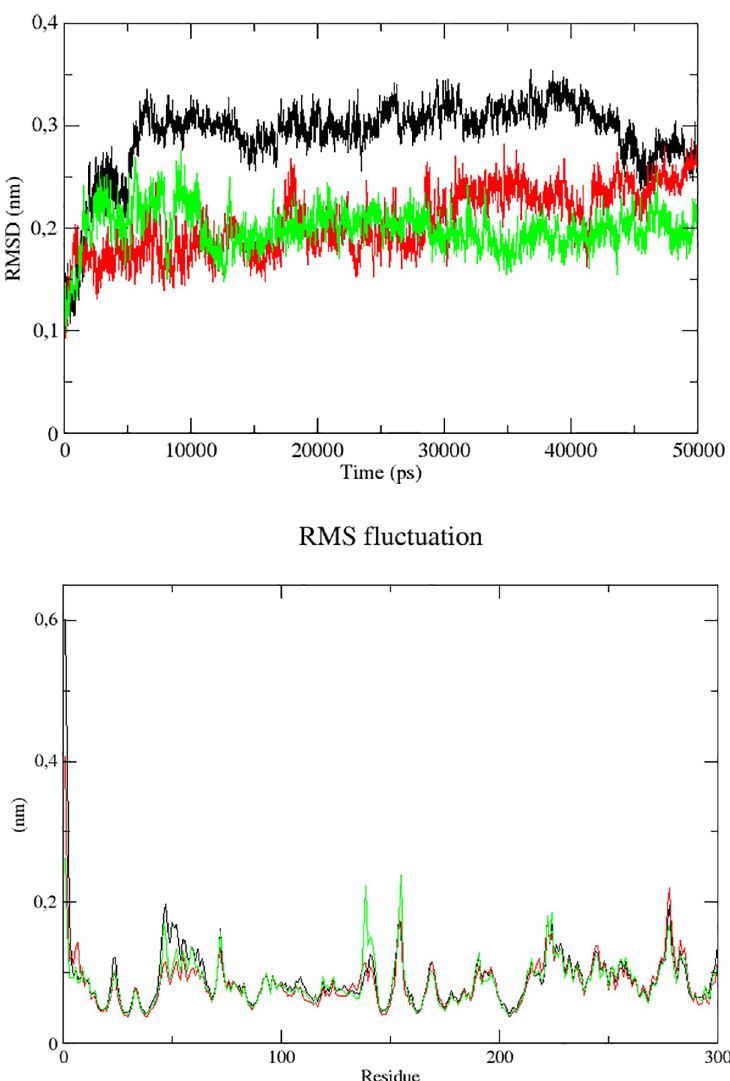
Fig 6. RMSD and RMSF plots for Mpro complex with quercetin -3 rhamnoside (black), myricetin 3-rutinoside (red) and rutin (green) for 50 ns.